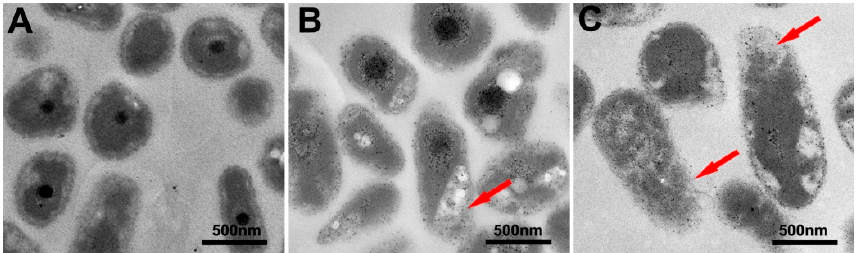
Figure 4. TEM images of R. solanacearum cells after incubation with: sterile water ( A ); resveratrol ( B ); and coumarin ( C ) for 2 h with final concentration 128 μ g/mL.